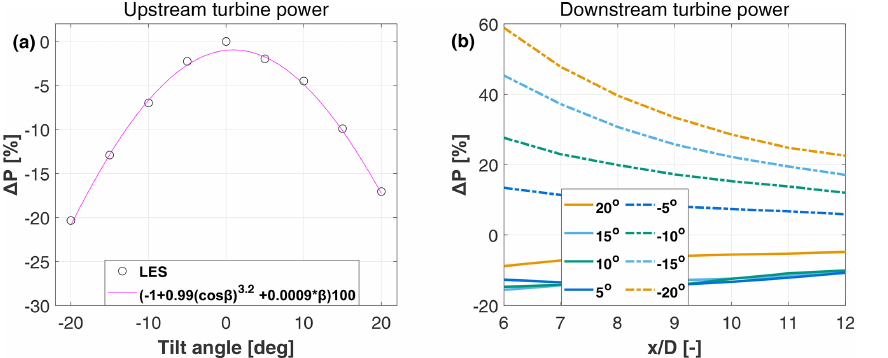
Figure 8. Power drop as a function of the tilt angle for the wake-steering turbine (a) . Power change in the wake as a function of the tilt angle and downstream distance (b) .